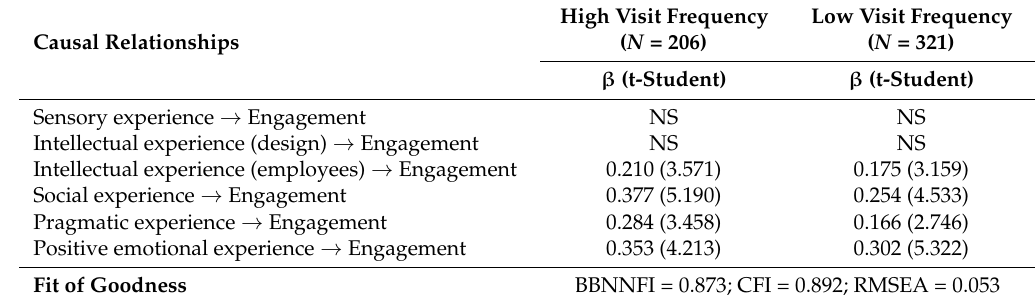
Table 8. Multi-group analysis: shoppers with high versus low visit frequencies.